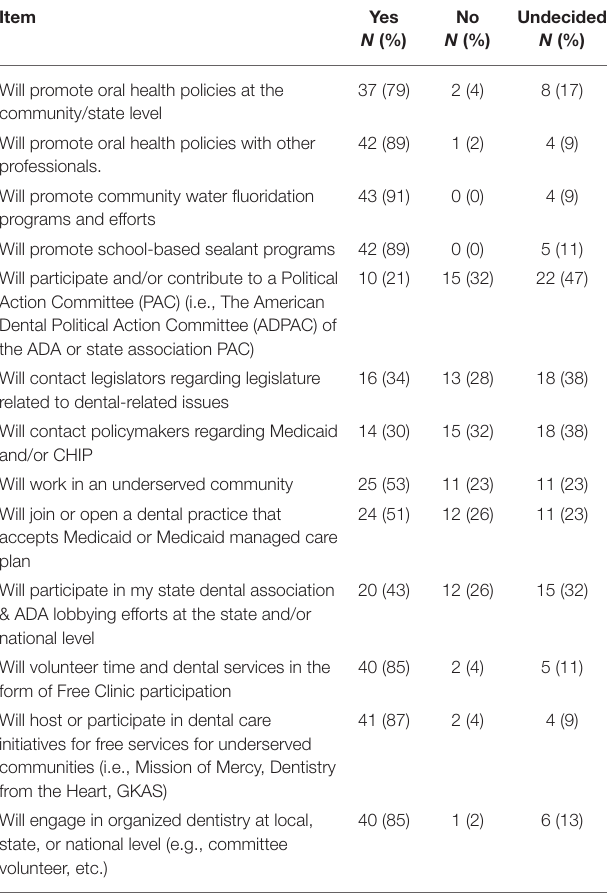
TABLE 4 | Intentions for Future Advocacy Involvement Post-Graduation (Total N =